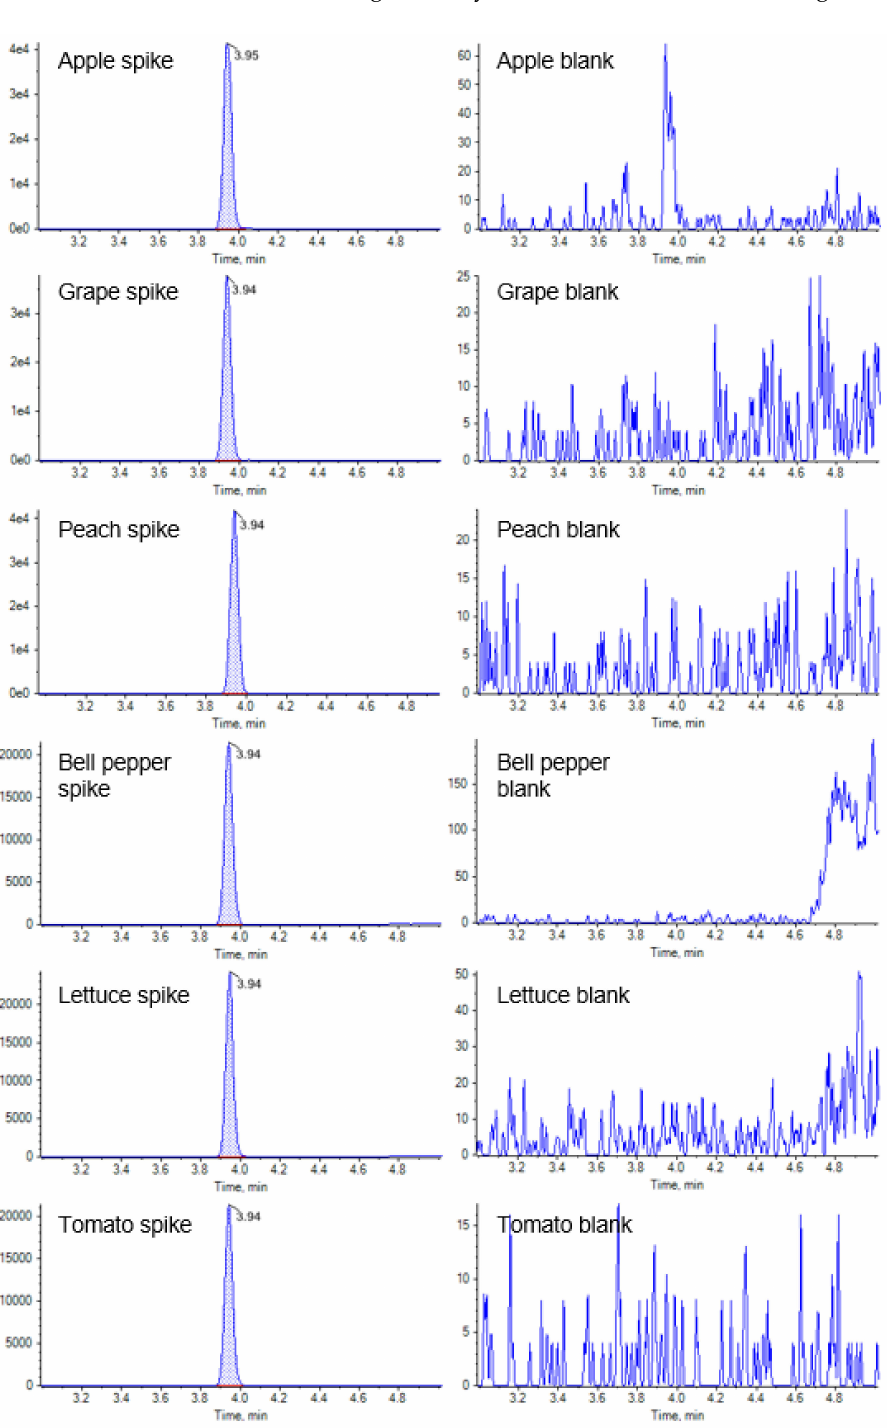
Figure 5. Typical MRM chromatograms of spiked (0.01 mg kg − 1 ) (left-hand column) and blank samples (right-hand